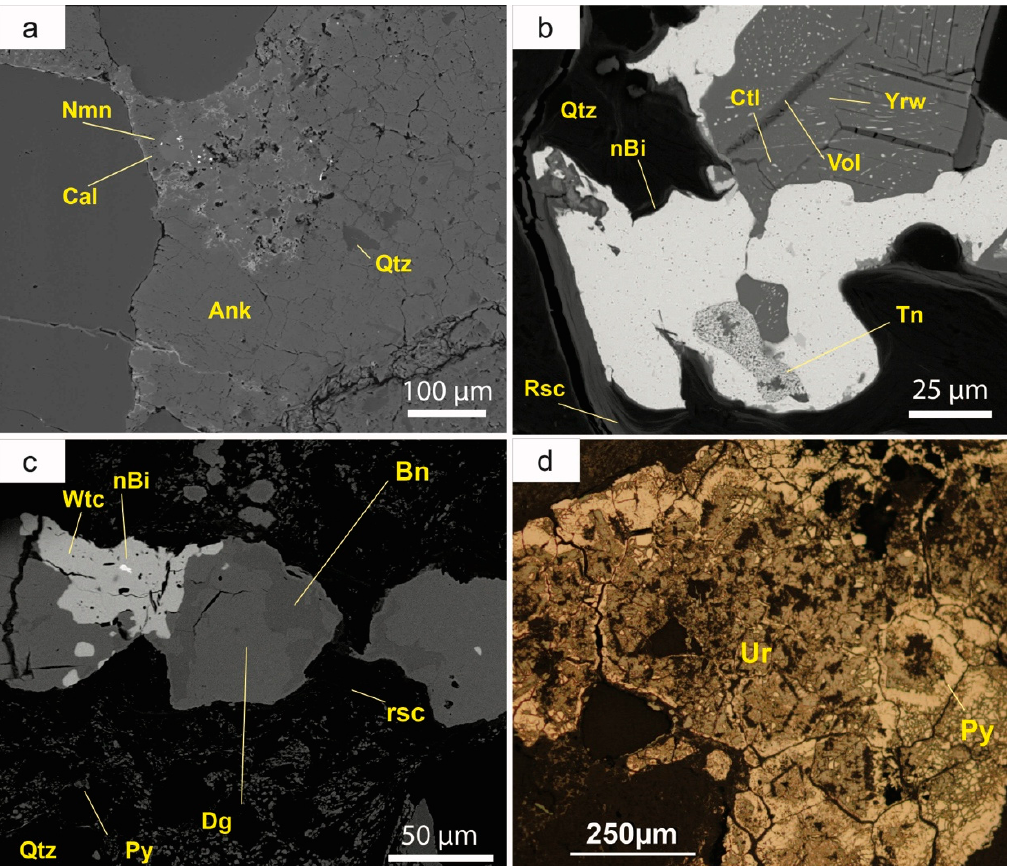
Figure 8. ( a ) Small grains of naumannite (Nmn) scattered in ankerite (Ank) and quartz (Qtz) replacing the early calcite cement (Cal); ( b ) Yarrowite (Yrw) with fine chlausthalite inclusions (Ctl) interstitial to quartz (Qtz) and roscoelite (Rsc). The former is replaced along grain boundaries by symplectitic native bismuth (nBi) with tennantite (Tn) and altered along cleavage by supergene volborthite (Vol); ( c ) Bornite (Bn) replaced by digenite (Dg), followed by native bismuth (nBi) and wittichenite (Wtc). Note pyrite (Py) and quartz (Qtz) in the groundmass; ( d ) Pyrite (Py) replaced along zoning by uraninite (Ur). (a–c) are SEM images, mode BSE; (d) is a reflected light image, in PPL.